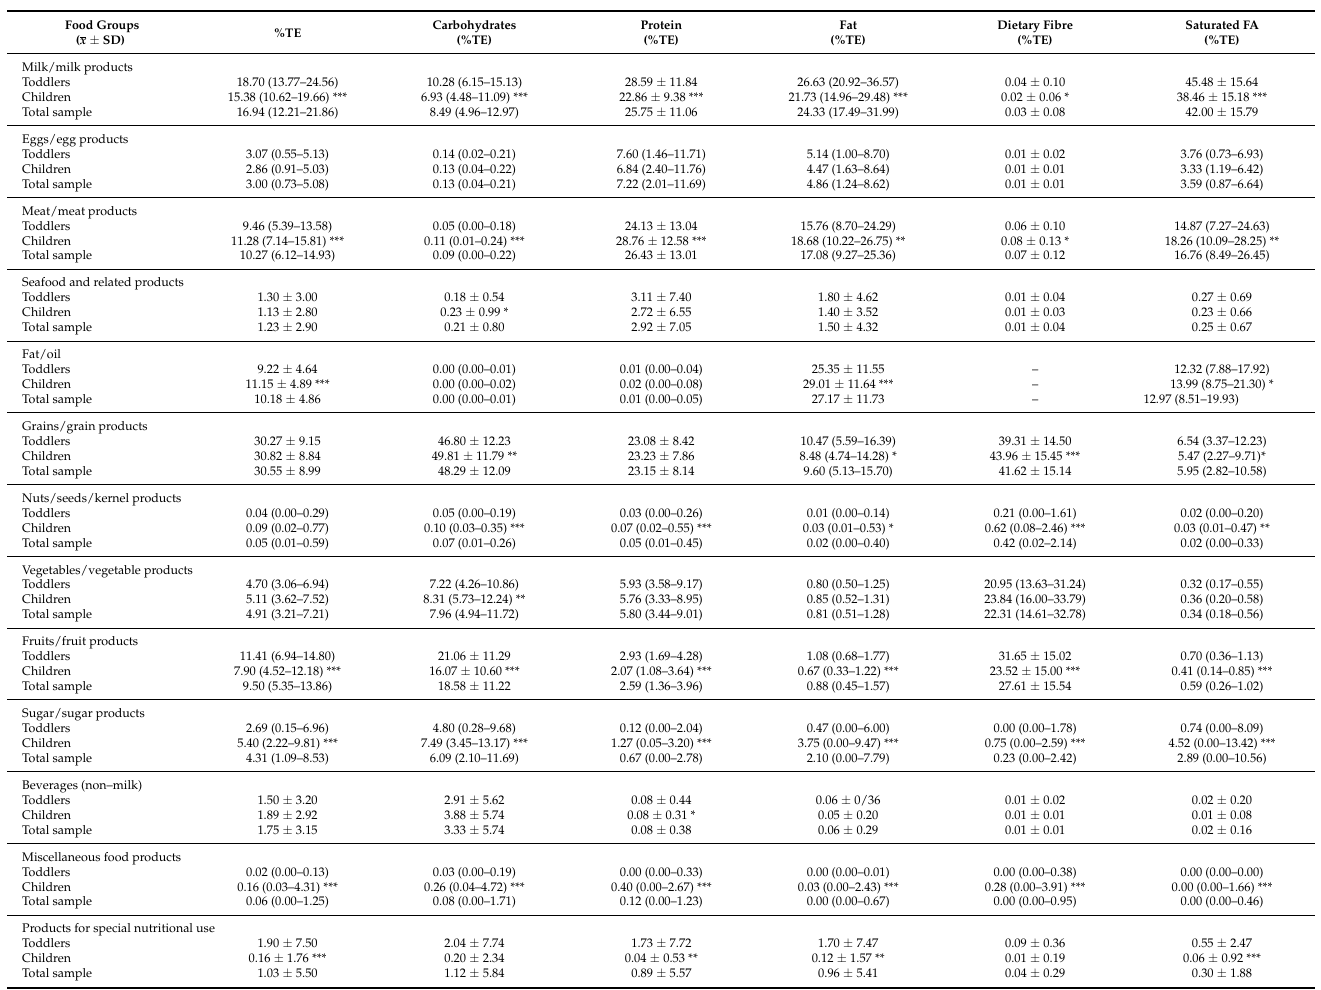
Table 6. Contribution of food groups to total energy intake and energy intake from carbohydrates, protein, fat, dietary fiber and saturated fatty acids across age and gender categories in a nationally representative sample of 1–3-year-old toddlers ( n = 290) and 3–9-year-old children ( n = 286) living in